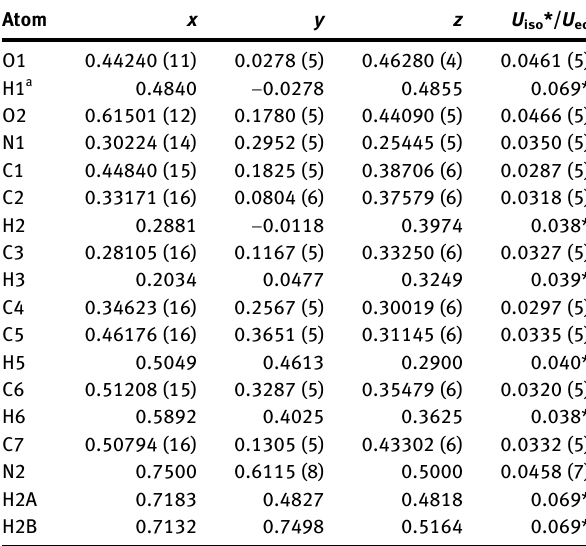
Table  : Fractional atomic coordinates and isotropic or equivalent isotropic displacement parameters (Å 